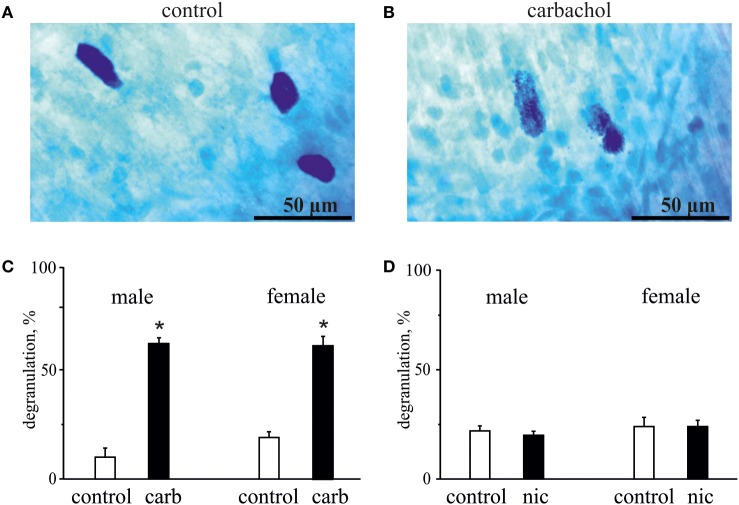
Action of carbachol and nicotine on degranulation of mast cells. (A) Example of intact well-shaped mast cells in control. (B) Example of degranulated mast cells (notice distorted borders) in the presence of 50 µM carbachol. (C) Histograms showing the effect of 50 µM carbachol on degranulation of mast cells obtained from male and female rats. (D) Histograms showing the effect of 100 µM nicotine on degranulation of mast cells obtained from male and female rats. Notice lack of nicotine effect on mast cell degranulation. Mean ± SD, n = 4, Mann–Whitney U test, *p < 0.05.